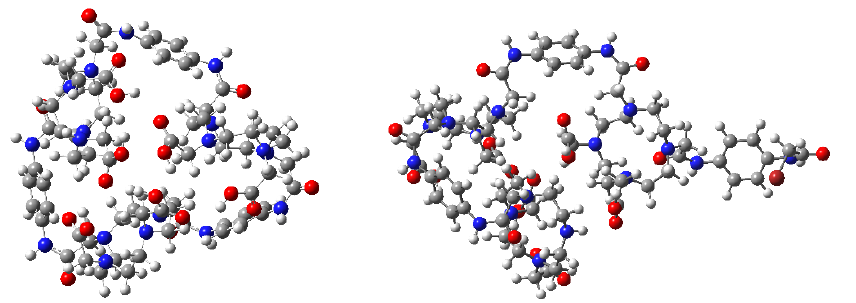
Figure 6. Optimized structures of the two considered system. Closed trimer, ( left ) and open trimer, ( right ) (C = gray, O = red, H = white and N = blue).